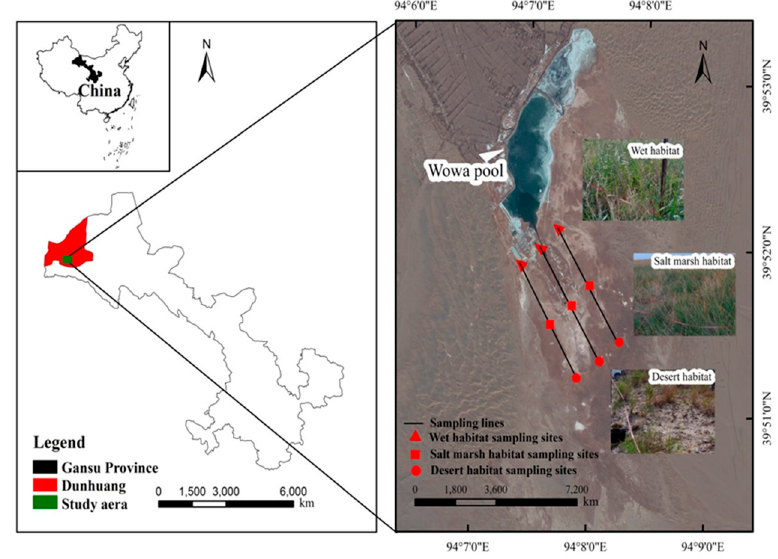
Figure 1. Study areas and sampling point distribution.